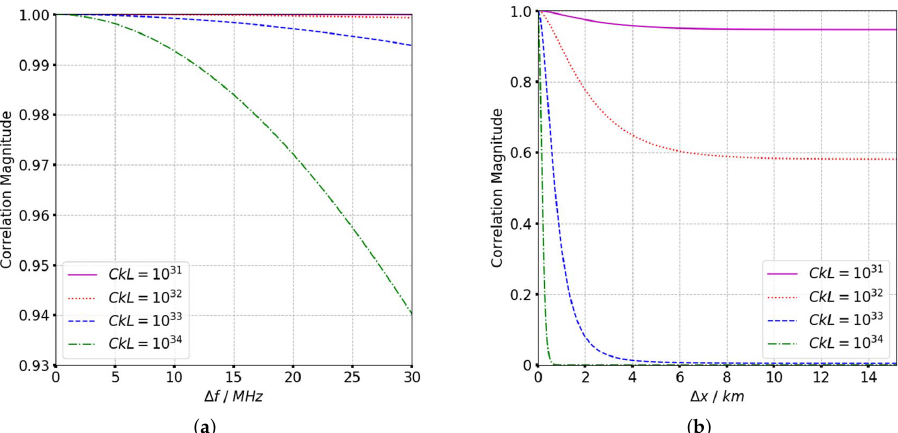
Figure 3. TFTPCF curves with different C k L . ( a ) TFTPCF versus frequency separation. ( b ) TFTPCF versus spatial